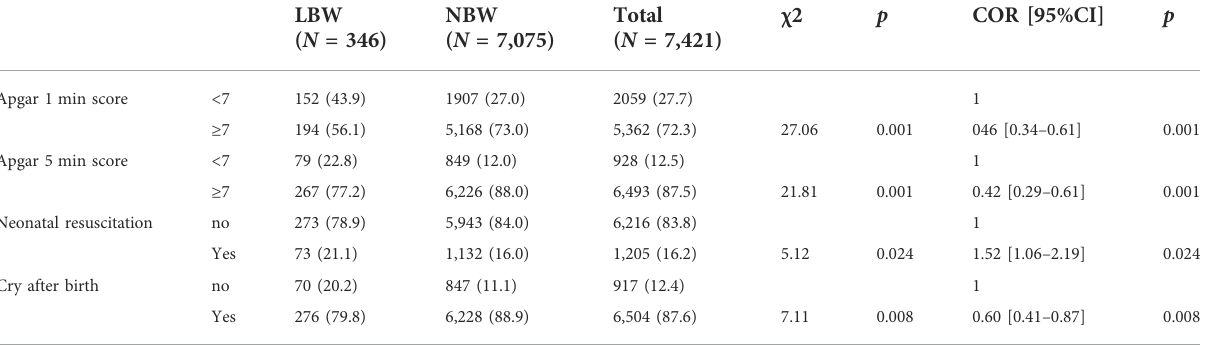
TABLE 3 Estimated risk of neonatal outcomes based on birth